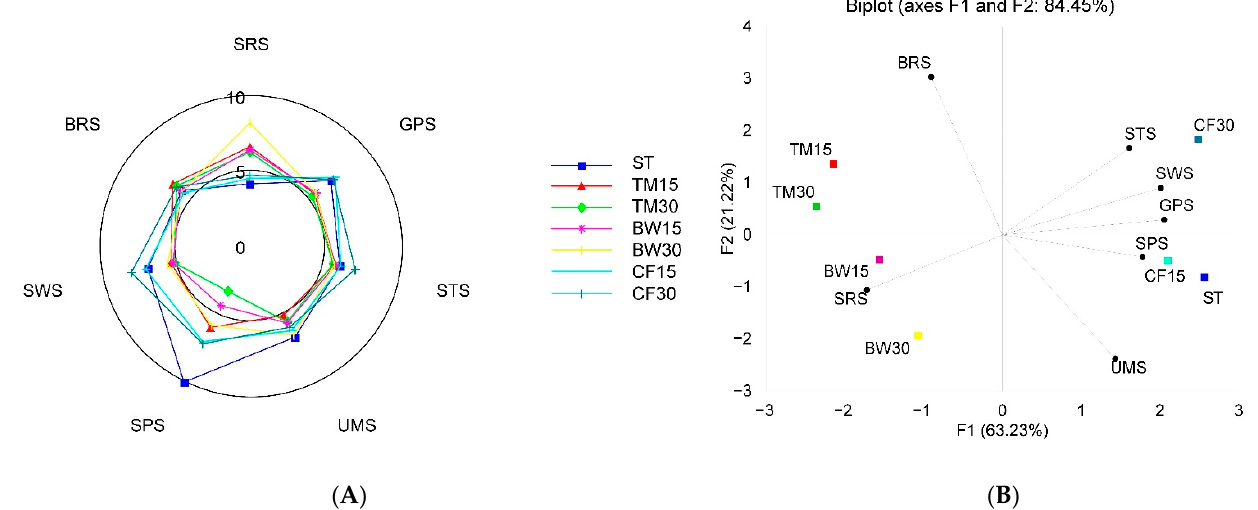
Figure 5. Radar chart representing the taste scores of bars ( A ) and a PCA graph showing the rela- tionship among samples and tastes. SRS—sourness, GPS—metallic, STS—saltiness, SPS—spiciness, UMS—umami, SWS—sweetness), and BRS—bitterness ( B ).